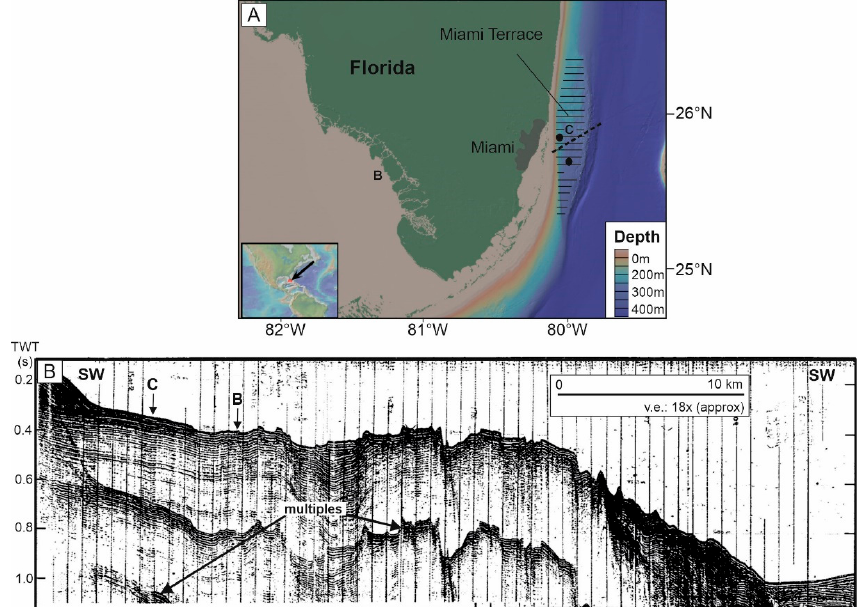
Figure 10. ( A ) Location map of the Straits of Florida and the Miami Terrace (horizontal lines). B-C location of sinkholes. Dashed line across Miami Terrace indicates location of Figure 6B. Figure made with GeoMapApp (www.geomapapp.org). ( B ) Seismic reflection profile WR-2 (RV Gyre, US Geological